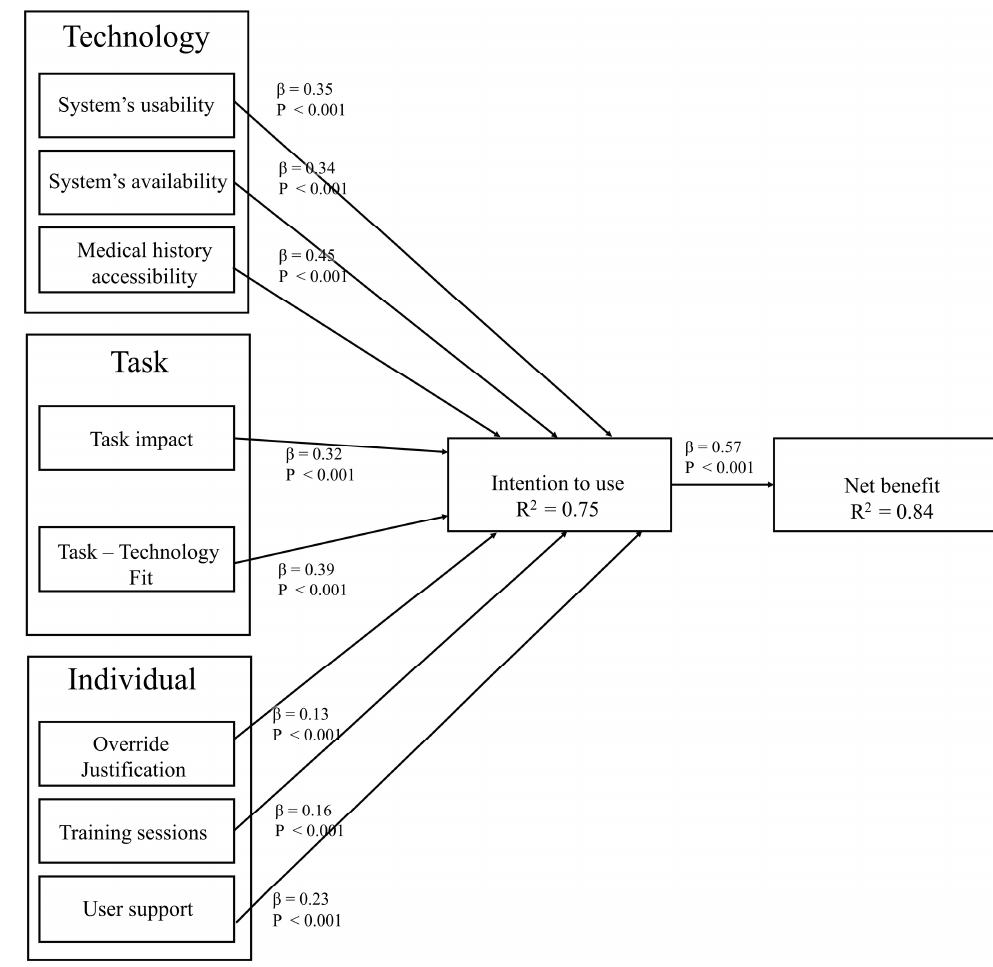
Figure 3. The structural model .